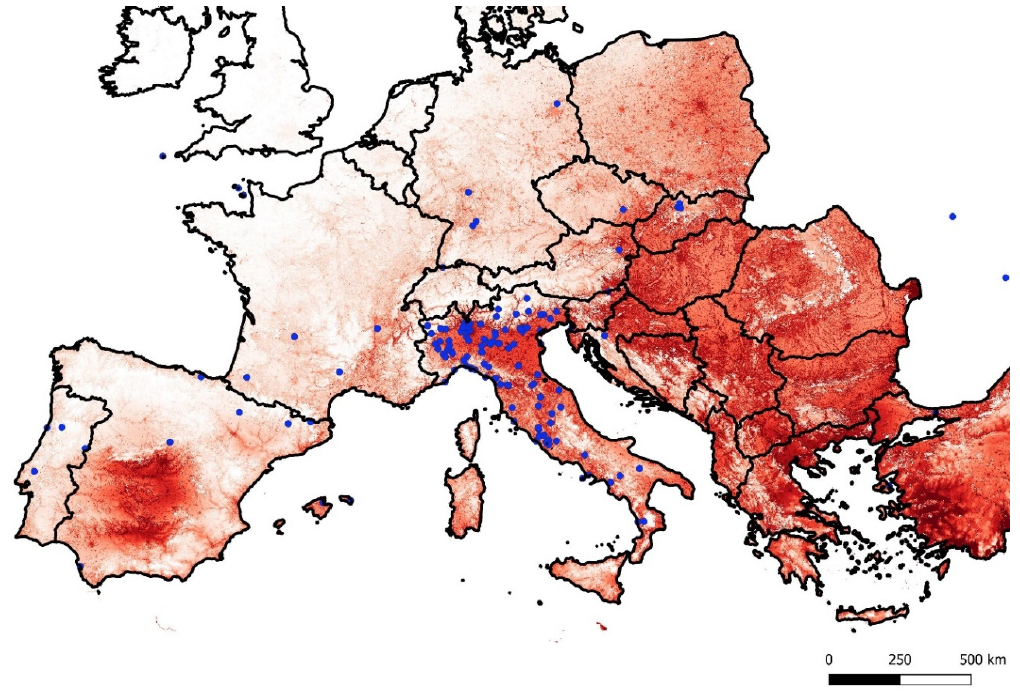
Figure 3. Potential distribution of C. suaveolens with the occurrence records shown in dark blue. White colour denotes unsuitable areas, whereas suitable areas are shown by a red gradient from poorly suitable sites in light red to highly suitable ones in dark red.